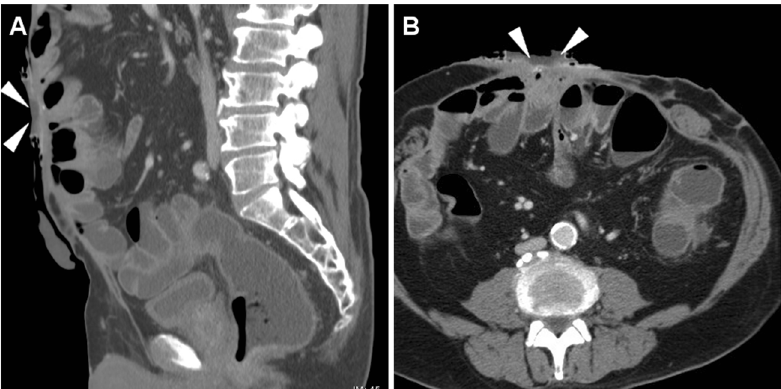
corresponded to a 2-cm hypoattenuating discontinuity (arrowheads) in the thickened skin, closely adherent to distended bowel loops with air- fluid levels consistent with